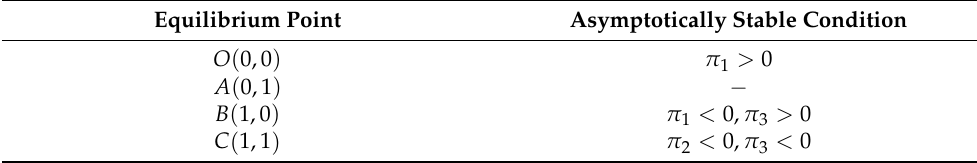
Table 4. Stability analysis